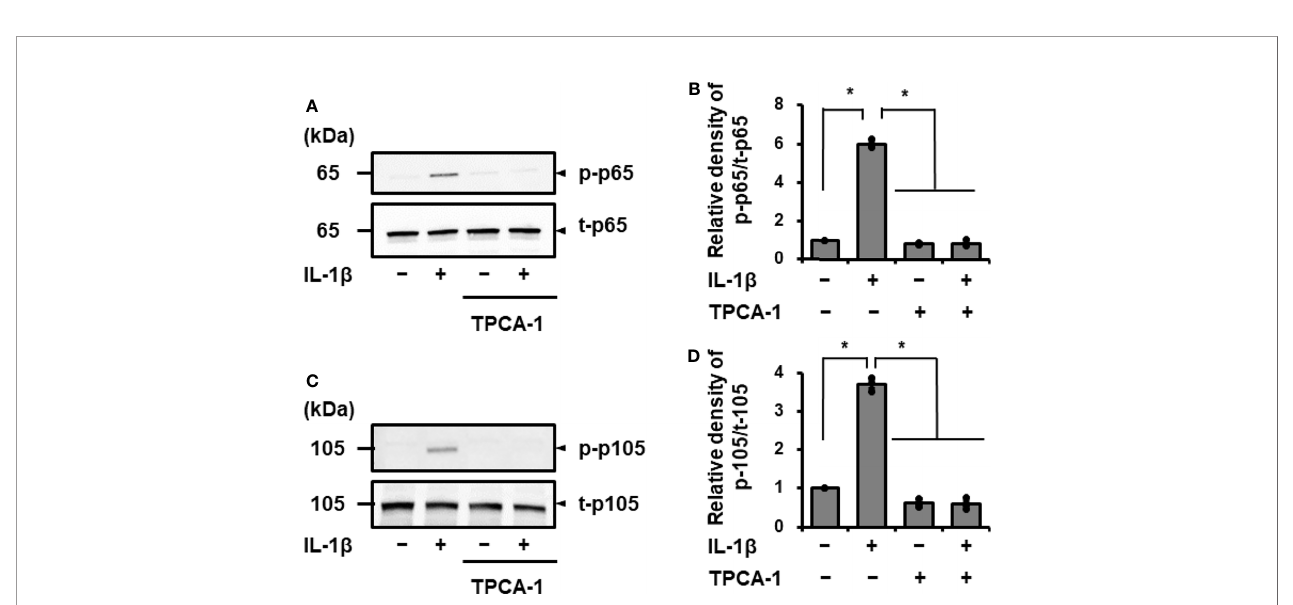
FIGURE 4 | Effect of the NF- k B inhibitor TPCA-1 on IL-1 b mediated phosphorylation of p65 and p105. Canine cardiac fi broblasts were pretreated with or without TPCA-1 (10 µM) for 1 h and stimulated with IL-1 b (100 pM) for 15 min. Representative western blotting results of inhibitory effect of TPCA-1 on IL-1 b -mediated phosphorylation of p65 (A) and p105 (C) , and relative levels of [p-65]/[t-65] (B) and [p-105]/[t-105] (D) as compared to those without the inhibitor and IL-1 b . Results have been represented as mean ± SE from biological triplicates. *P